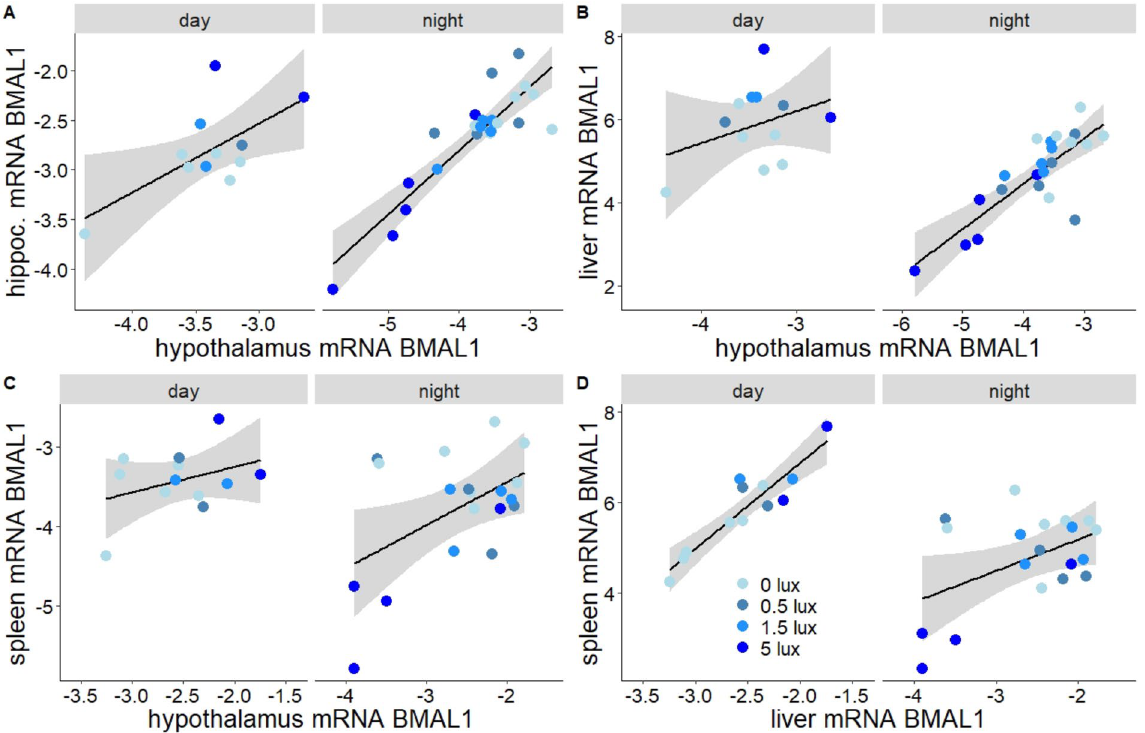
Figure 4. ALAN effects on BMAL1 expression were comparable in different tissues. Correlation of expression patterns of BMAL1 in different tissues. Shown are log-transformed mRNA levels, separated by sampling time (day vs night) and ALAN treatments (blue colour gradient). Points represent individual birds. Lines and shaded areas depict model estimated means ± 95% confidence intervals. Panels show expression levels of BMAL1 in hypothalamus in relation to ( A ) hippocampus, ( B ) liver and ( C ) spleen, as well as spleen in relation to liver ( D